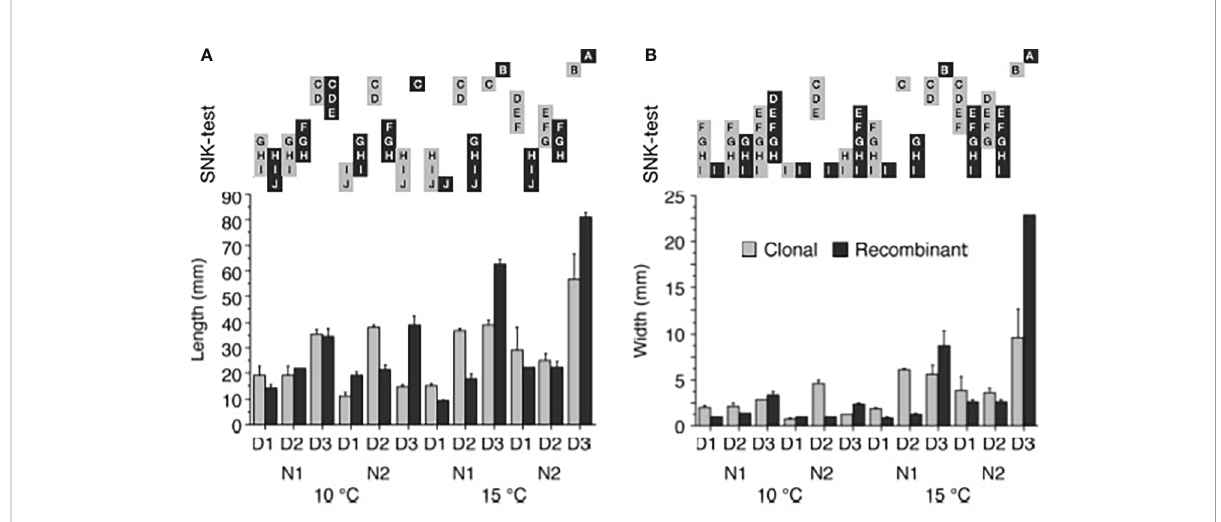
FIGURE 3 Ulva growth. (A) Length (mm), and (B) width (mm) of Ulva fenestrata clonal and recombinant gametophytes after 12 weeks culture under different environmental conditions (10°C and 15°C, N1 = PES and N2 = 3xPES, D1 = 10 000 swarmers ml -1 , D2 = 5000 swarmers ml -1 and D3 = 500 swarmers ml -1 , for further explanations see text). Letters above bars denote signi fi cant differences based on the Student Newman Keul´s (SNK) post hoc test. Treatments with non-overlapping letters are signi fi cantly different (SNK, p < 0.05). Error bars show + SEM (n =